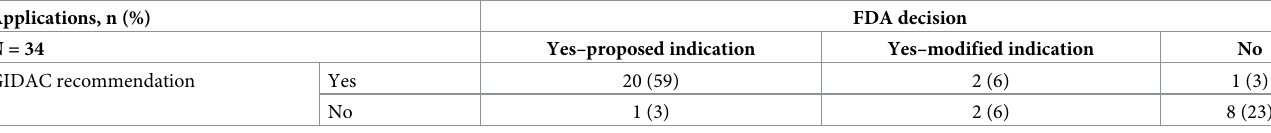
Table 2. Committee recommendations and subsequent FDA